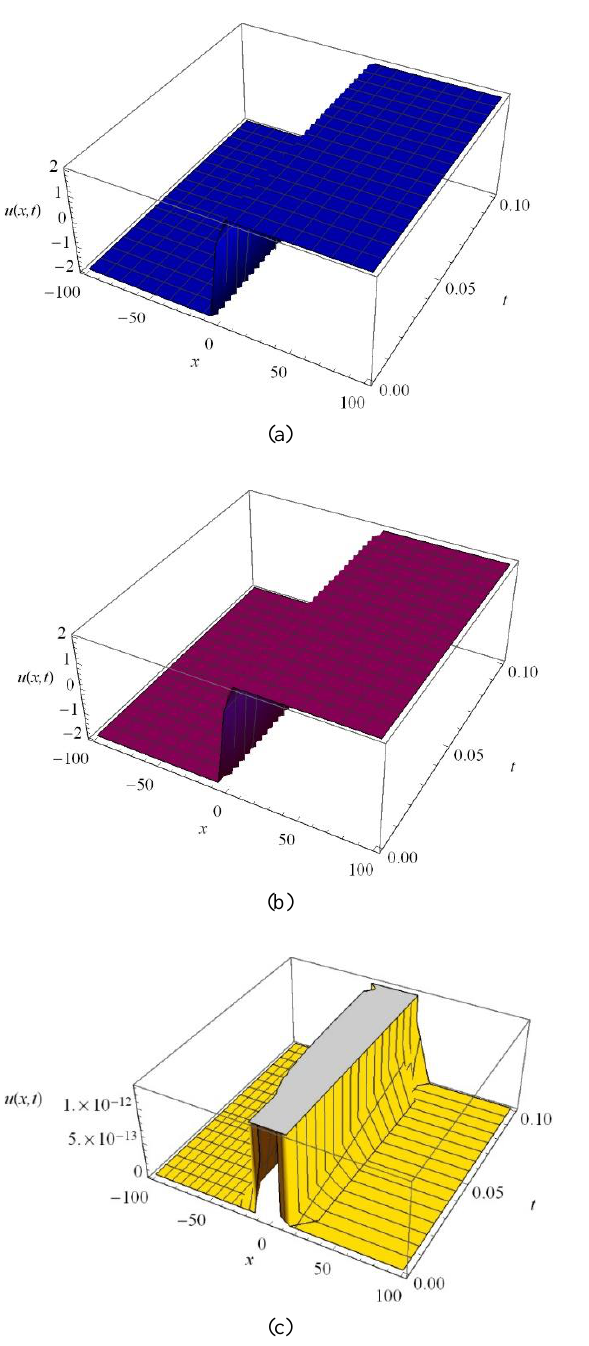
Figure 1. 3D plots of (a) q -HAETM solution (b) Exact solution (c) Absolute error = |𝑢 𝐸𝑥𝑎𝑐𝑡 − 𝑢 𝐴𝑝𝑝. | at 𝛼 = 1, 𝑛 = 1,𝑎 = 1,𝑘 = 1, 𝑤 = 0.5, and ℏ = −1 .